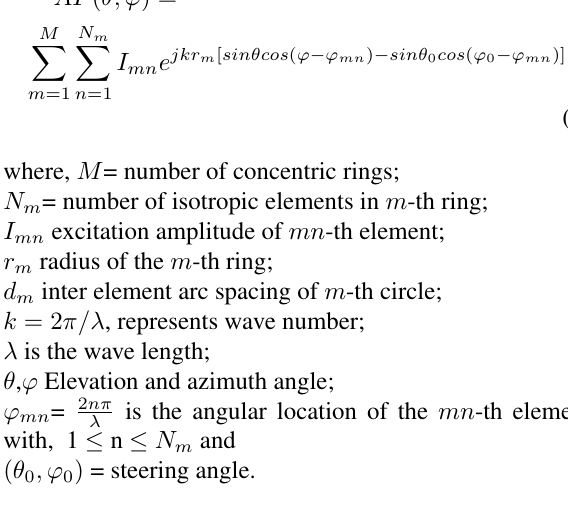
true global minima with less control parameters and